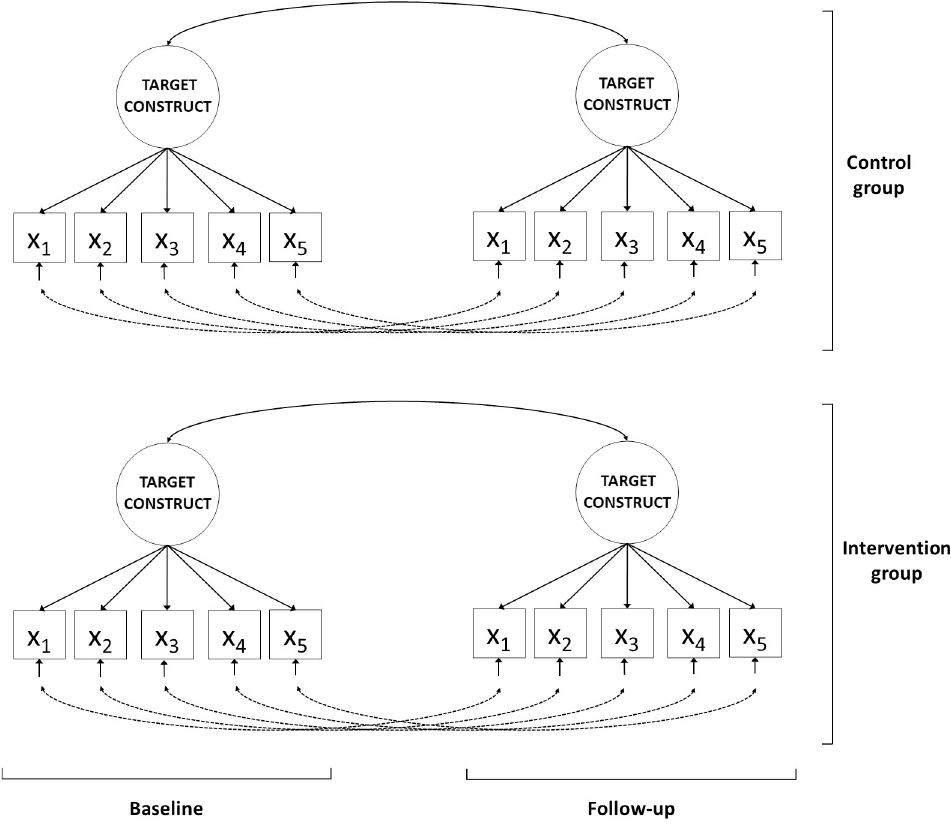
Fig 1. An example of the measurement model used for response shift investigation. Notes : The squares represent observed variables, i.e., questionnaire scores (X), measured at both baseline and follow-up assessment. The solid single- headed arrows at the bottom represent the residual factors of each observed variable. The dotted double-headed arrow represents the relations between the residual factors, where the residual factors of the same observed variable are allowed to correlate over time. The circles represent the target construct that the observed variables aim to measure (e.g., insomnia severity, depression, or personal meaning; both at baseline and follow-up assessment). Each arrow from a circle to an observed variable represents a factor loading. The double-headed arrows between the circles represent the correlations between the target construct over time.